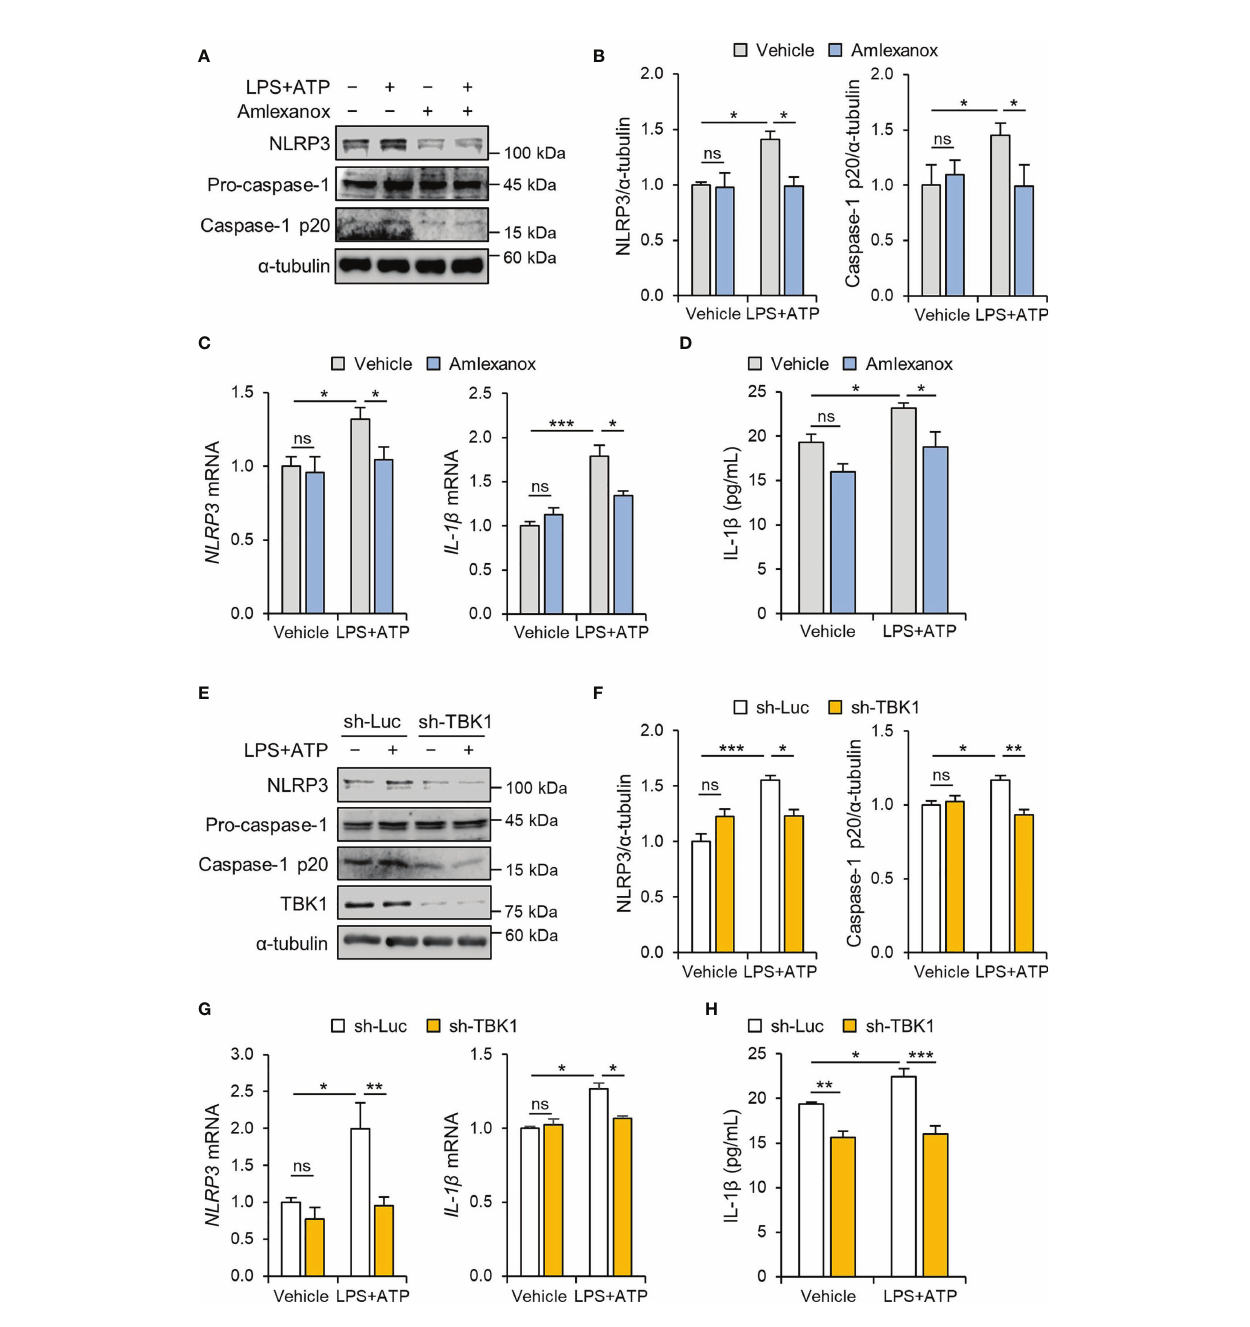
FIGURE 2 | TBK1 de fi ciency abolishes LPS-induced NLRP3 in fl ammasome activation in trophoblasts. (A – C) HTR-8/SVneo cells were treated with 1 m g/mL LPS or 20 µM amlexanox for 24 h (A, B) or 12 h (C) followed by treatment with 5 mM ATP for 45 min, as indicated in the fi gure. (A, B) Cell lysates were analyzed by immunoblotting with anti-NLRP3 and anti-caspase-1 antibodies. (C) Relative mRNA expression of NLRP3 and IL-1 b was quanti fi ed by qRT-PCR. (D) Conditioned media were collected from HTR-8/SVneo cells treated with 1 m g/mL LPS or 10 µM amlexanox for 36 h followed by treatment with 5 mM ATP for 45 min, as indicated in the fi gure. IL-1 b levels were quanti fi ed by ELISA. (E – G) HTR-8/SVneo cells were infected with lentiviruses expressing shRNAs targeting luciferase (sh- Luc) or TBK1 (sh-TBK1) and treated with 1 m g/mL LPS for 24 h (E, F) or 12 h (G) followed by treatment with 5 mM ATP for 45 min, as indicated in the fi gure. (E – G) Cell lysates were analyzed by immunoblotting with anti-NLRP3, anti-caspase-1, and anti-TBK1 antibodies. (G) Relative mRNA expression of NLRP3 and IL-1 b was quanti fi ed by qRT-PCR. a -tubulin served as a loading control. Band intensities were quanti fi ed and normalized to control band intensities. (H) Conditioned media were collected from HTR-8/SVneo cells infected with sh-Luc or sh-TBK1 lentiviruses and treated with 1 m g/mL LPS for 24 h followed by treatment with 5 mM ATP for 45 min, as indicated in the fi gure. IL-1 b levels were quanti fi ed by ELISA. Data are shown as means ± SEM. Results are representative of at least three independent experiments. * p < 0.05; ** p < 0.01; *** p < 0.001; ns, not signi fi cant (One-way ANOVA, followed by Tukey ’ s